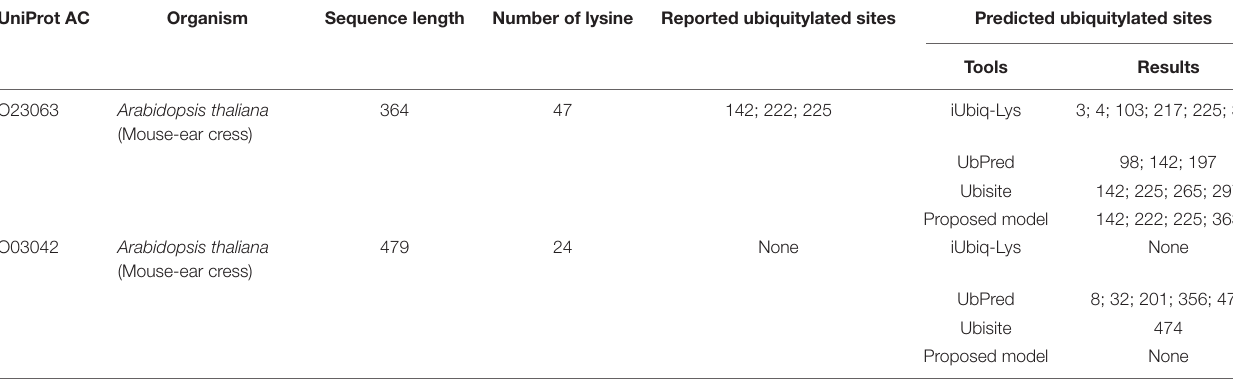
TABLE 5 | Performance comparison with other tools on two types of single